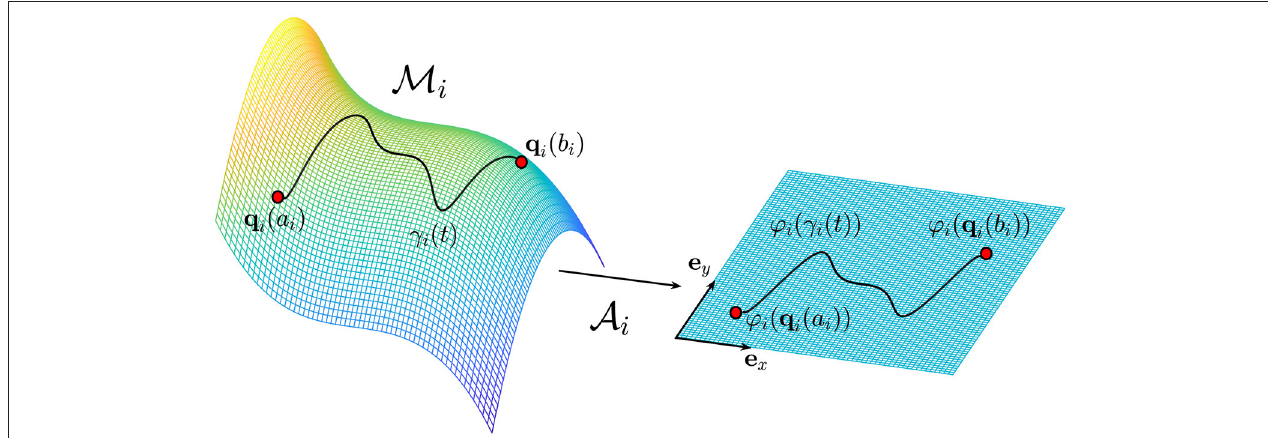
FIGURE 1 | The trajectory γ i on the manifold M i represents the evolution of the i -th biological process which starts at q i ( a i ) and ends at q i ( b i ), where a i , b i ∈ R + . The atlas A i provides the connection with the Euclidean space R 2 identified by the two unit vectors e x and e y .